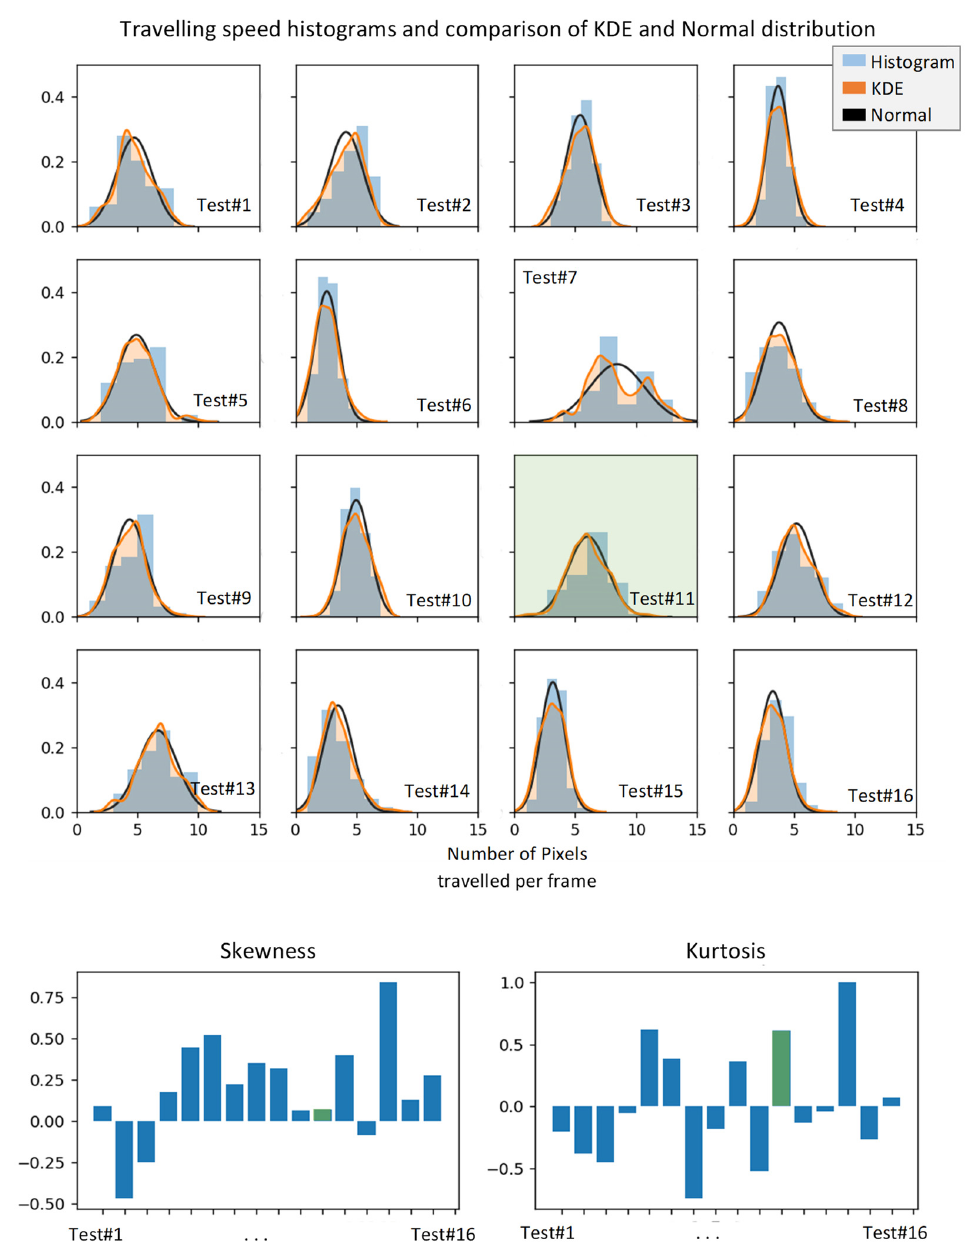
Figure 5. Statistical parameters representing the uniformity and consistency of the carrier speed.